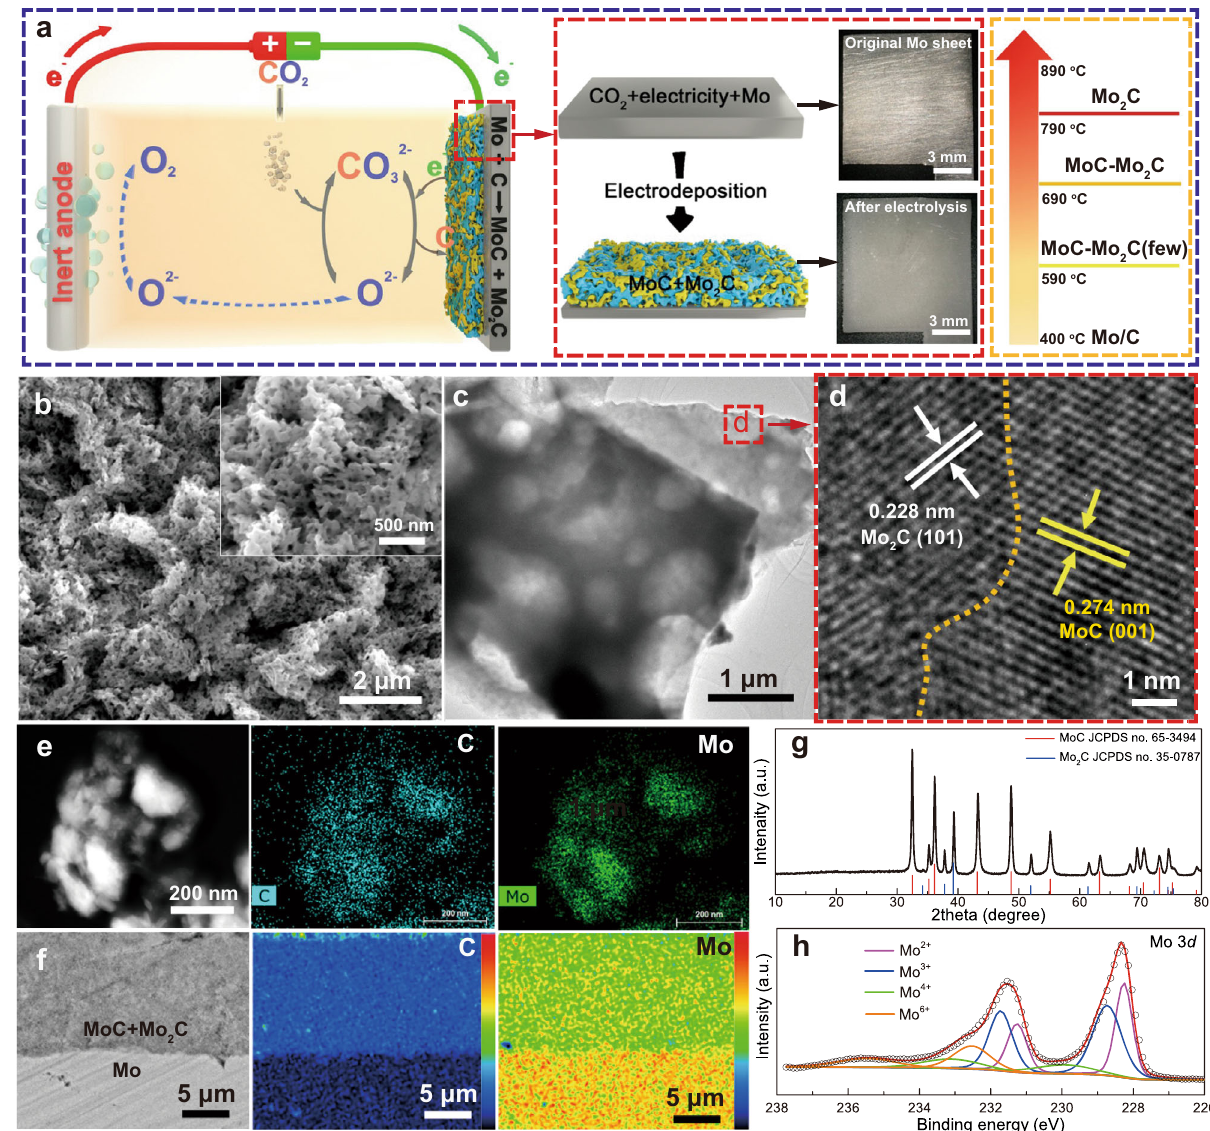
Fig. 1 Materials synthesis and characterization. a Schematic of preparing the MoC – Mo 2 C-790 in molten carbonate and digital pictures of the Mo electrode before and after electrolysis. b SEM images of the synthesized MoC – Mo 2 C-790, the inset is an enlarged view of the 3D hierarchical honeycomb- like structures on the surface of MoC – Mo 2 C-790. c TEM image of the samples collected from the MoC – Mo 2 C-790. d High-resolution transmission electron microscopy (HRTEM) image of the powders from the MoC – Mo 2 C-790. e HAADF-STEM image and the corresponding EDS mapping of the MoC – Mo 2 C-790. f Cross-sectional SEM images (BSE) with their corresponding element distribution mappings by EPMA of the MoC – Mo 2 C-790. g XRD pattern of the MoC – Mo 2 C-790. h XPS pattern of the MoC – Mo 2